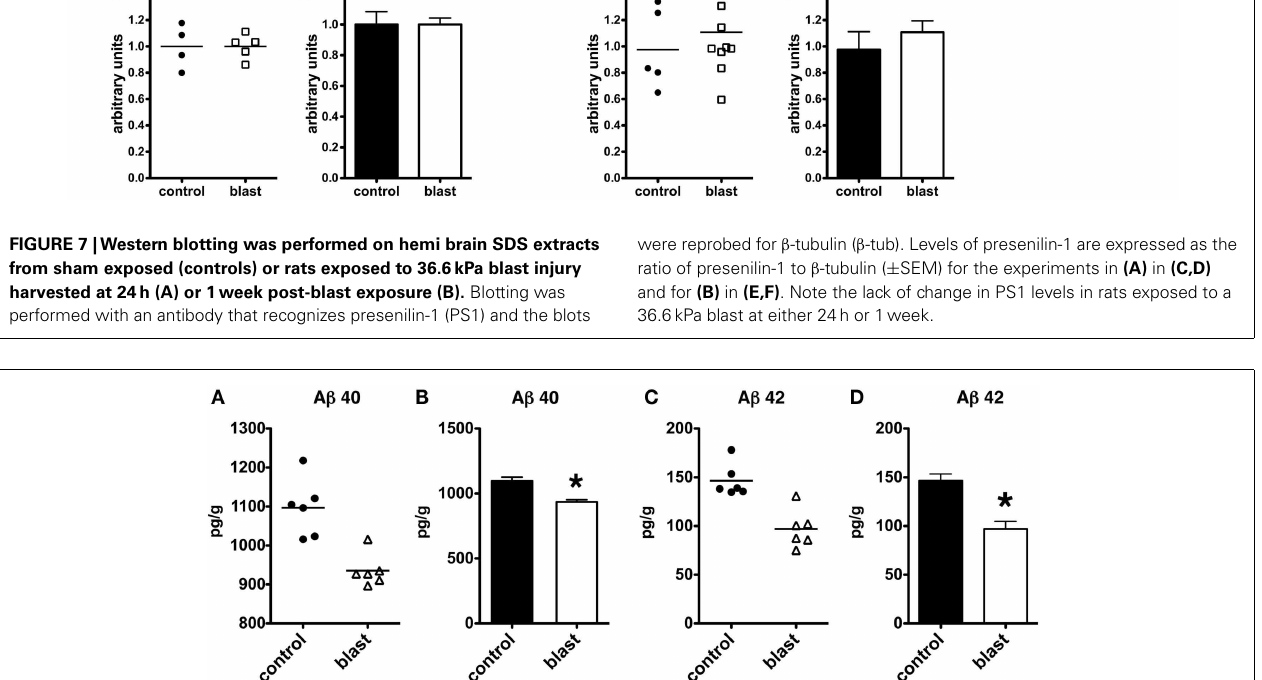
FIGURE 8 | Enzyme-linked immunosorbent assays forA β 40 (A,B) and 42 (C,D) were performed on total brain extracts from mice exposed to blast injuries of 147kPa and harvested at 24h post-blast exposure. Controls